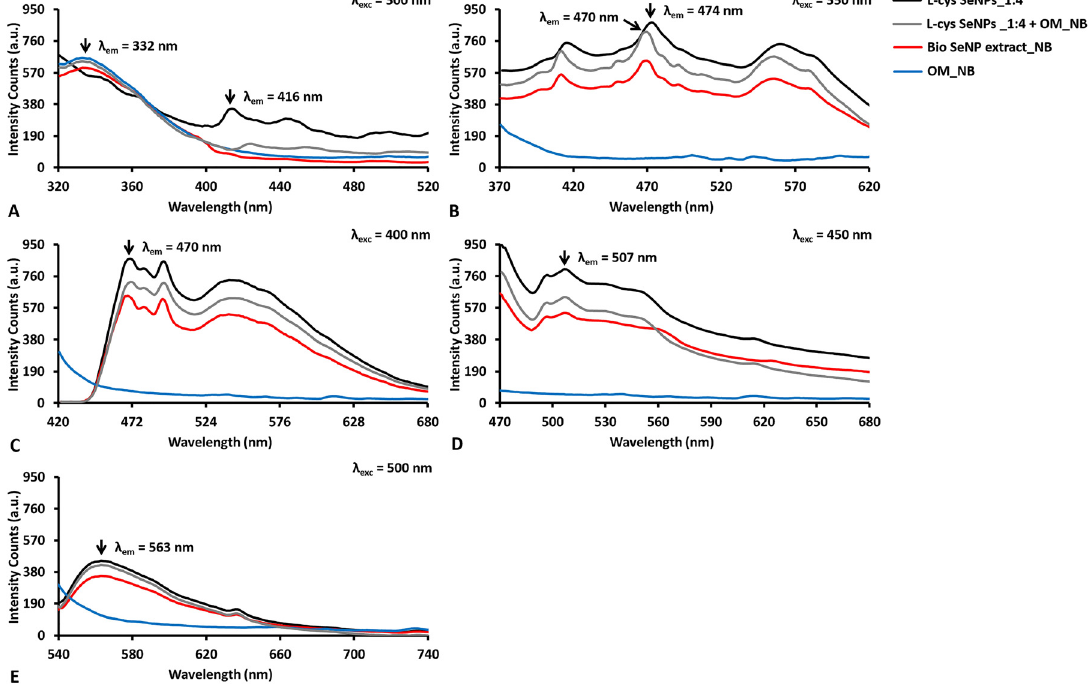
Figure 6: Emission photoluminescence spectra collected for SeNPs of ca. 100 nm as average diameter (i.e., L -cys SeNPs_1:4, Bio SeNP extract_NB,and L -cysSeNPs_1:4 + OM_NB)andtheircorrespondingOM(i.e.,OM_NB)uponexcitationat(A)300,(B)350,(C)400,(D)450,and (E) 500